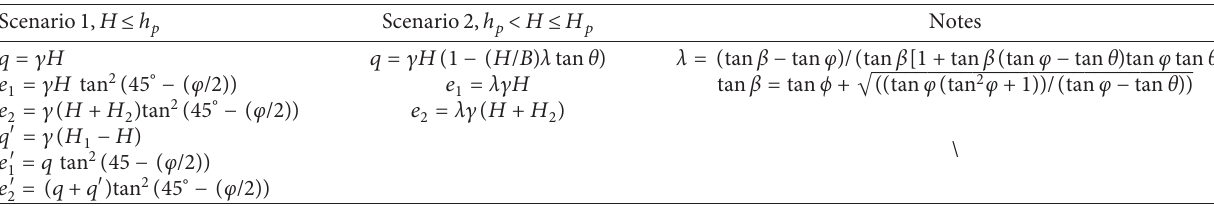
Table 1: The pressures on the double-arched tunnel.